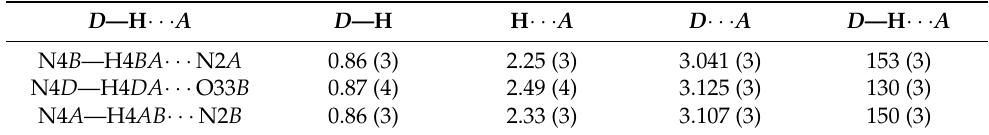
Table 4. Hydrogen-bond geometry (Å, °) for 3a . Table 5. Hydrogen bond geometry (Å, ◦ ) in 3b